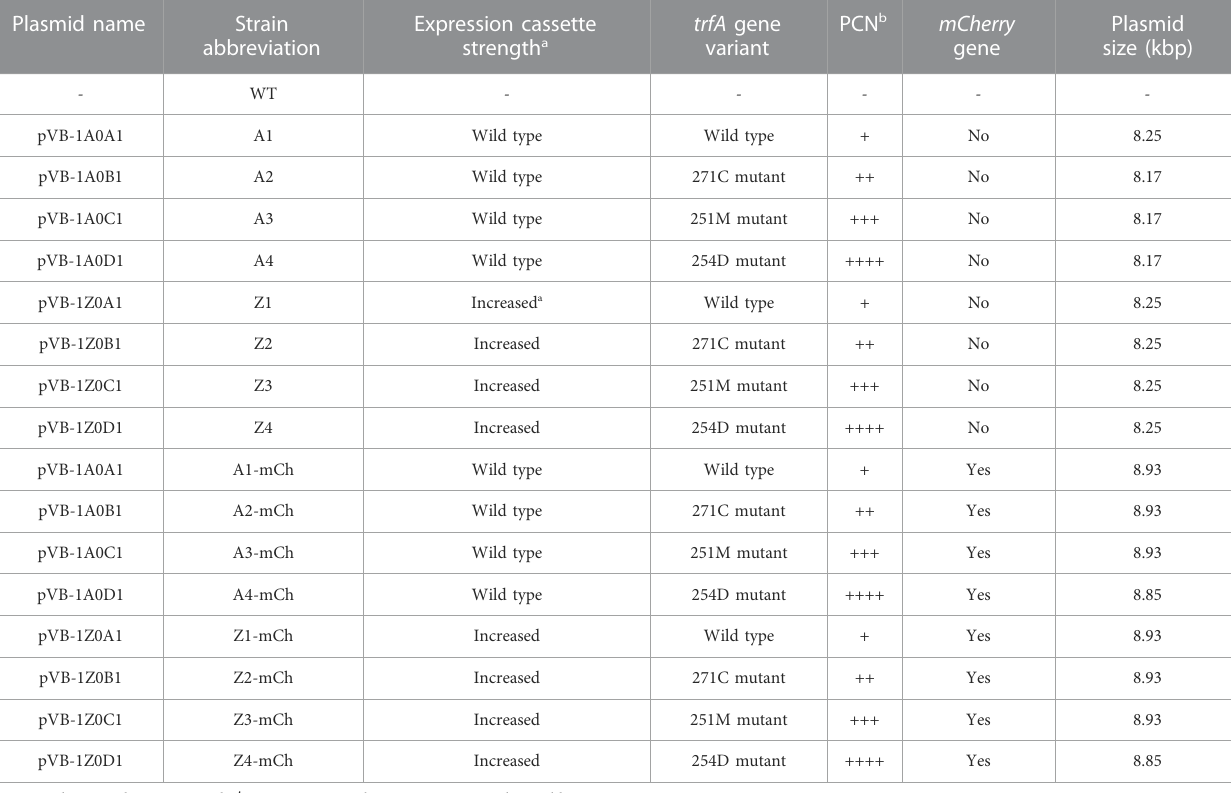
TABLE 1 Expression vector name, resulting strain abbreviation, expression cassette strength, regulator gene trfA variant, plasmid copy number (PCN), presence/ absence of the mCherry gene and plasmid size of the bacterial strains used in the present work. All strains derive from the Escherichia coli BL21 wild-type (WT) strain. Plasmids were provided by Vectron Biosolutions